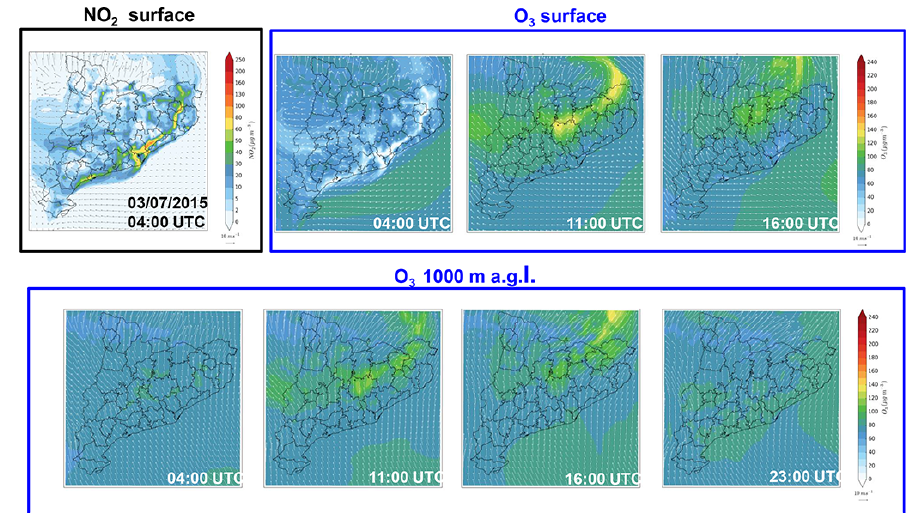
Figure 15. Maps of simulated NO 2 and O 3 concentrations at ground level with wind vectors at 10ma.g.l. and at 1000ma.g.l. with wind vectors at the same altitude, for selected hours on 3 July 2015.